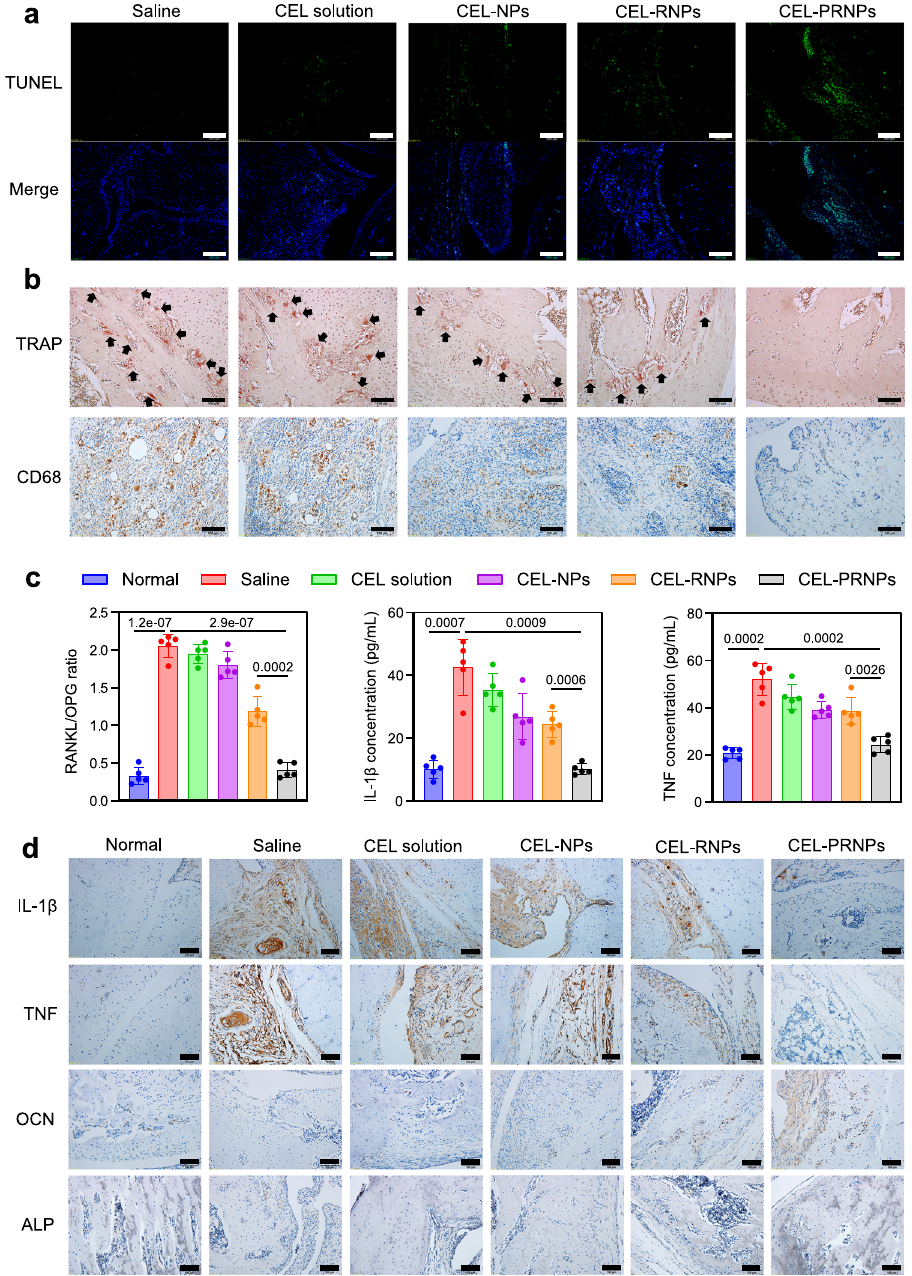
Fig. 7 CEL-PRNPs reduce the number of OCs and in fl ammatory macrophages in joints of rats with advanced arthritis. a TUNEL immuno fl uorescence staining in ankle joints from AIA rats receiving the indicated treatment (Scale bar = 200 μ m) ( n = 5 independent animals). b Immunohistochemical analyses of the TRAP-stained OCs and CD68-stained synovial macrophages in the joint tissues from rats receiving the indicated treatment (Scale bar = 100 μ m) ( n = 5 independent animals). c RANKL/OPG ratio in arthritic joints, IL-1 β secretion in blood, and TNF secretion in blood from rats receiving the indicated treatment. Data represent mean ± SD ( n = 5 independent animals). Statistical signi fi cance was determined by a two-sided Student ’ s t test. d Detection of IL-1 β , TNF, OCN, and ALP expression levels in arthritic joints in different groups. Arthritic joints in different groups were stained with IL-1 β , TNF, and OCN antibodies, respectively. ALP was stained light – dark in arthritic joints from different groups (Scale bar = 100 μ m) ( n = 5